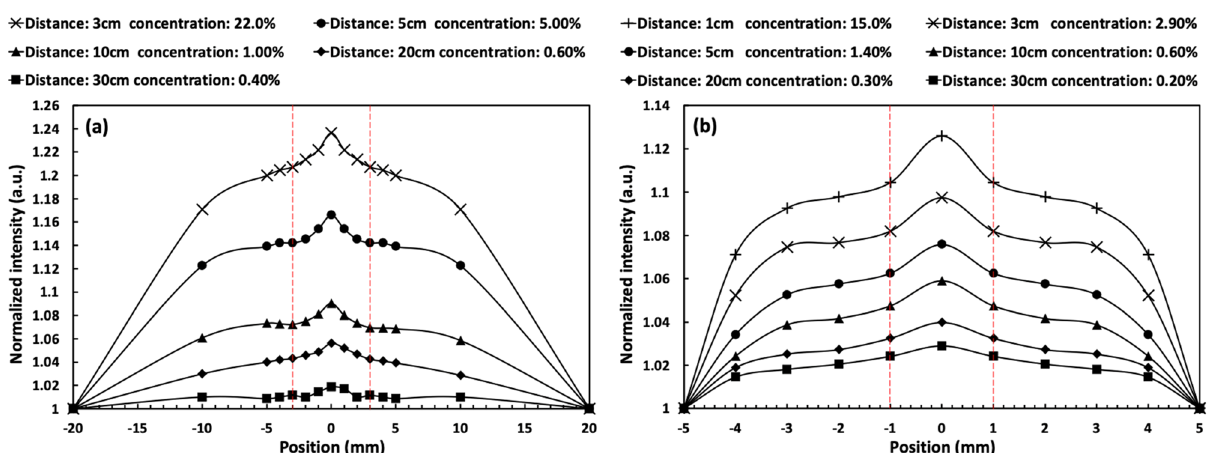
Figure 4. Observed transverse intensity distributions when the annular beam with ( a ) 40 mm and ( b ) 10 mm diameters are propagated in media cells with different lengths from 1 to 30 cm. The red dash-dotted lines indicate the regions ( a ) ± 3 mm and ( b ) ± 1 mm that are used to distinguish the central peak from the hill-like broaden signal. Here, position means the distance from optical